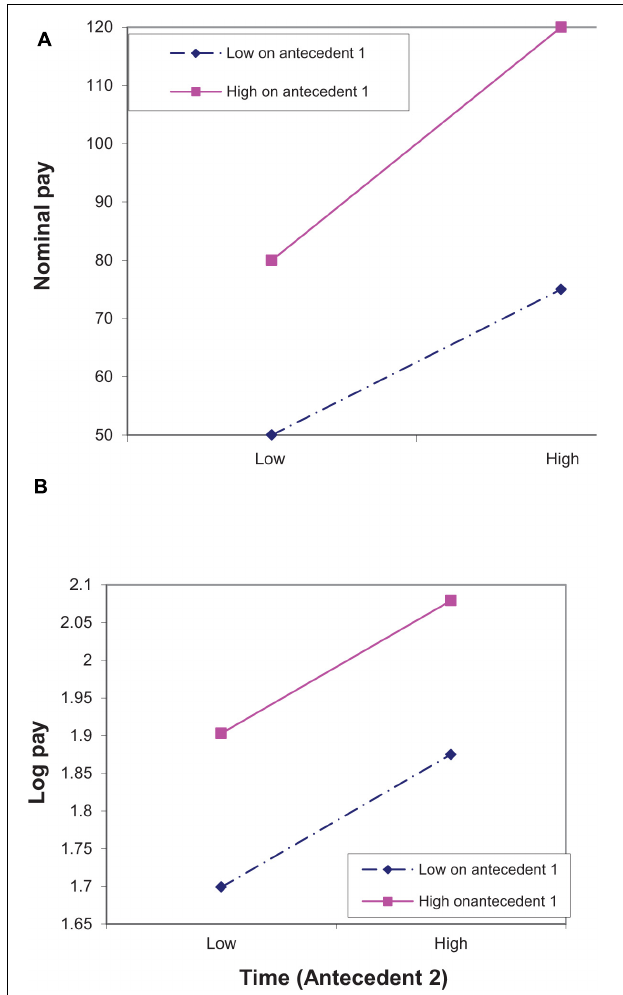
FIGURE 1 | An illustration of Type I error in detecting interactions between two antecedents when the true model of pay is logarithmic. The antecedents can be either two individual characteristics or an individual characteristic and time. In (A) the dependent variable is nominal pay and in Figure 2A it is log pay. The points in (B) are associated with the points in (A) . Thus, for example, log(50) ≈